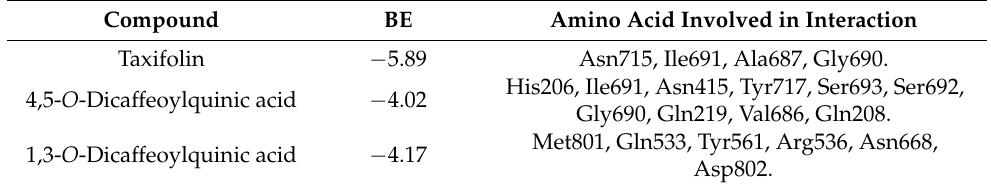
Table 5. Binding energy and amino acids involved in the interactions between α -glucosidase en- zyme and the docked compounds.